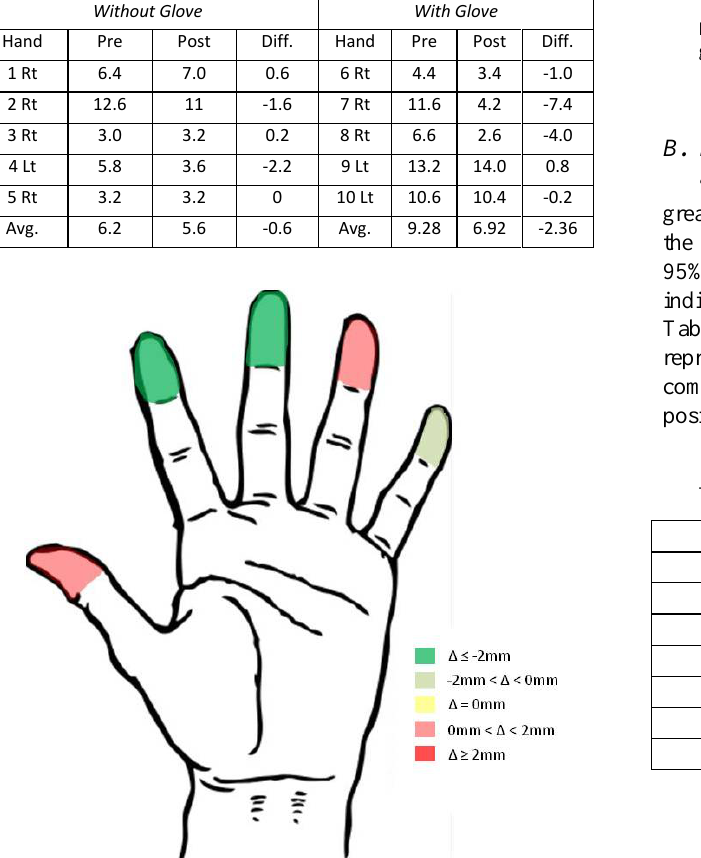
Fig. 11. Graphical depiction of 2-point discriminator test results “without glove.”